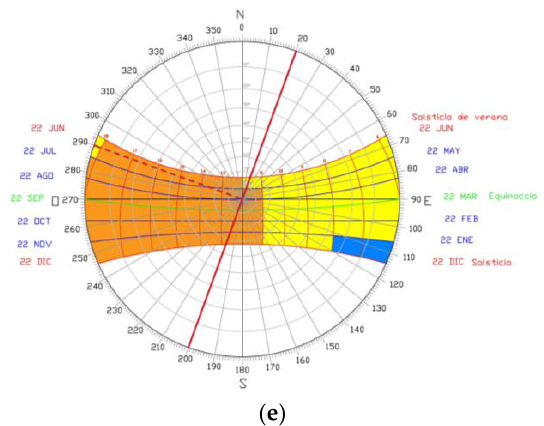
Figure 6. Façades (solid lines) and azimuth (dashed lines) of the lot represented in the solar chart for January to June: ( a ) Façade A, ( b ) Façade B, ( c ) Façade C, ( d ) Façade D, and ( e ) Fa ç ade E.